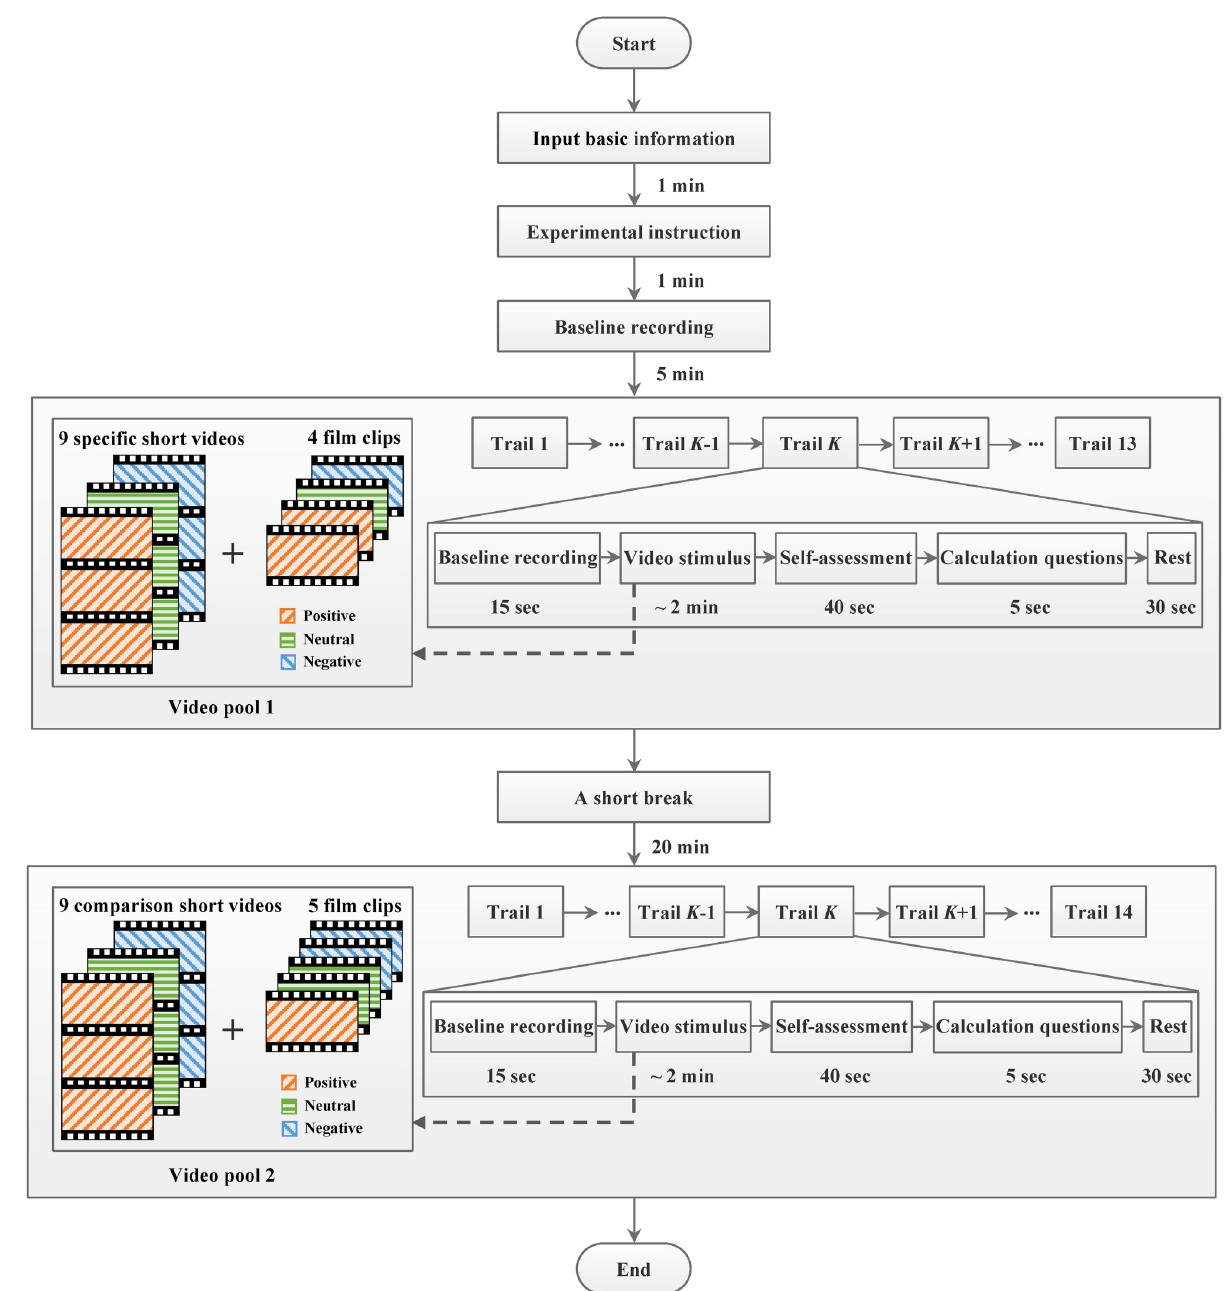
Fig 11. The flowchart of EEG signal acquisition